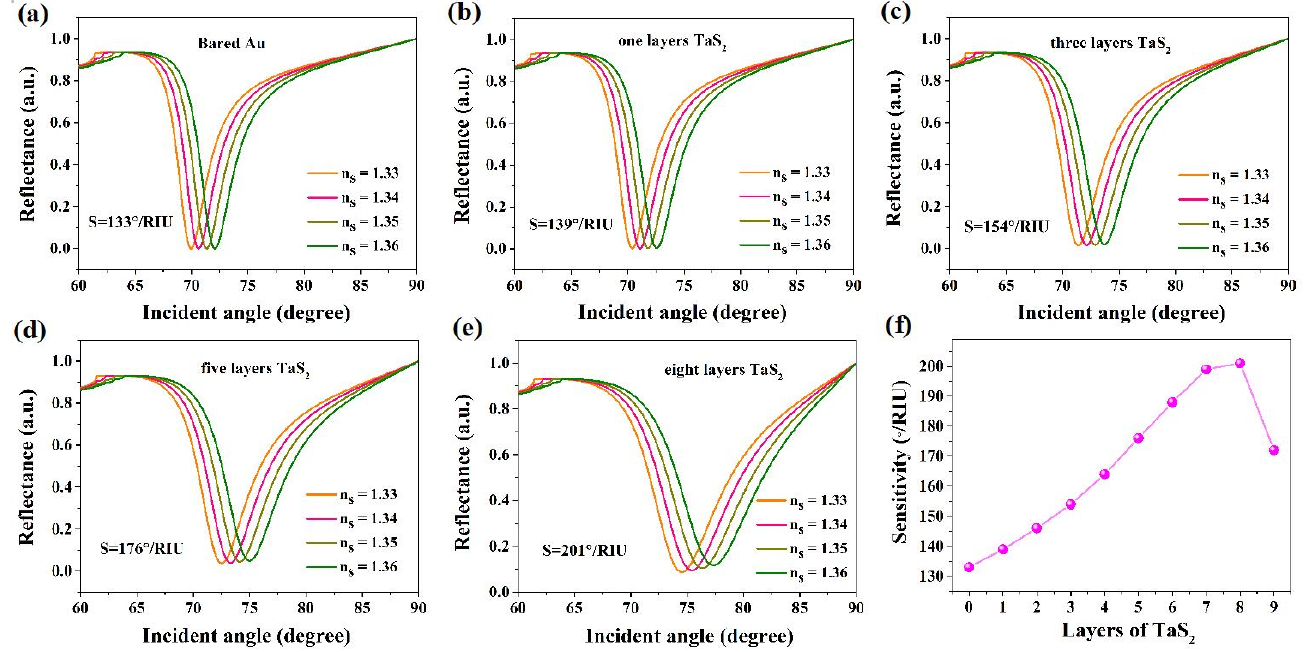
Figure 2. ( a – e ) Simulation change of reflectivity relative to incident angles with different numbers of TaS 2 nanosheets; ( f ) variation of sensitivity with respect to the number of TaS 2 nanosheets.